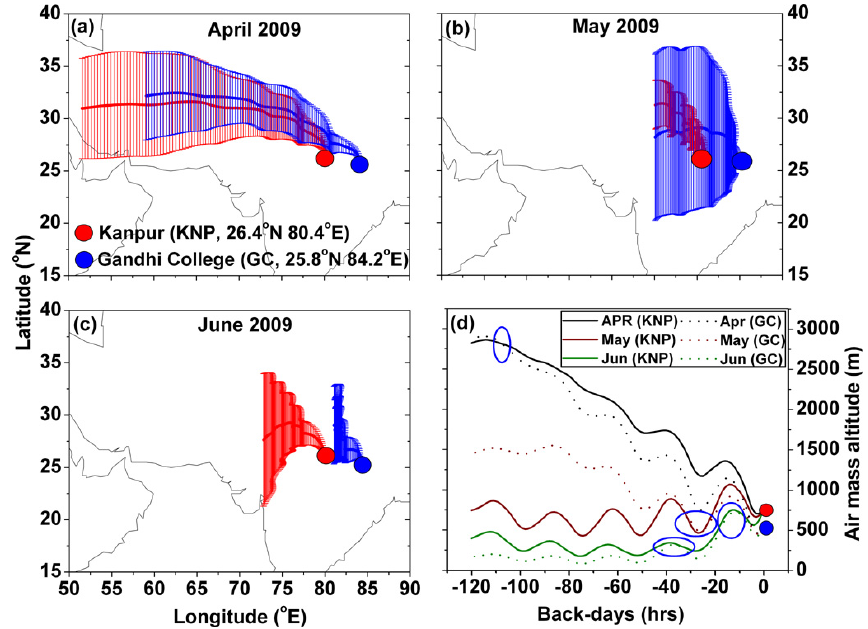
Fig. 5. 5-day air mass back-trajectory clusters at Kanpur and Gandhi College during (a) April 2009, (b) May 2009 and (c) June 2009 (vertical lines show standard deviations, represent spreading of air masses). (d) Air mass altitude variations with back-days at Kanpur (KNP, with solid lines) and Gandhi College (GC, with dotted lines) during April to June.